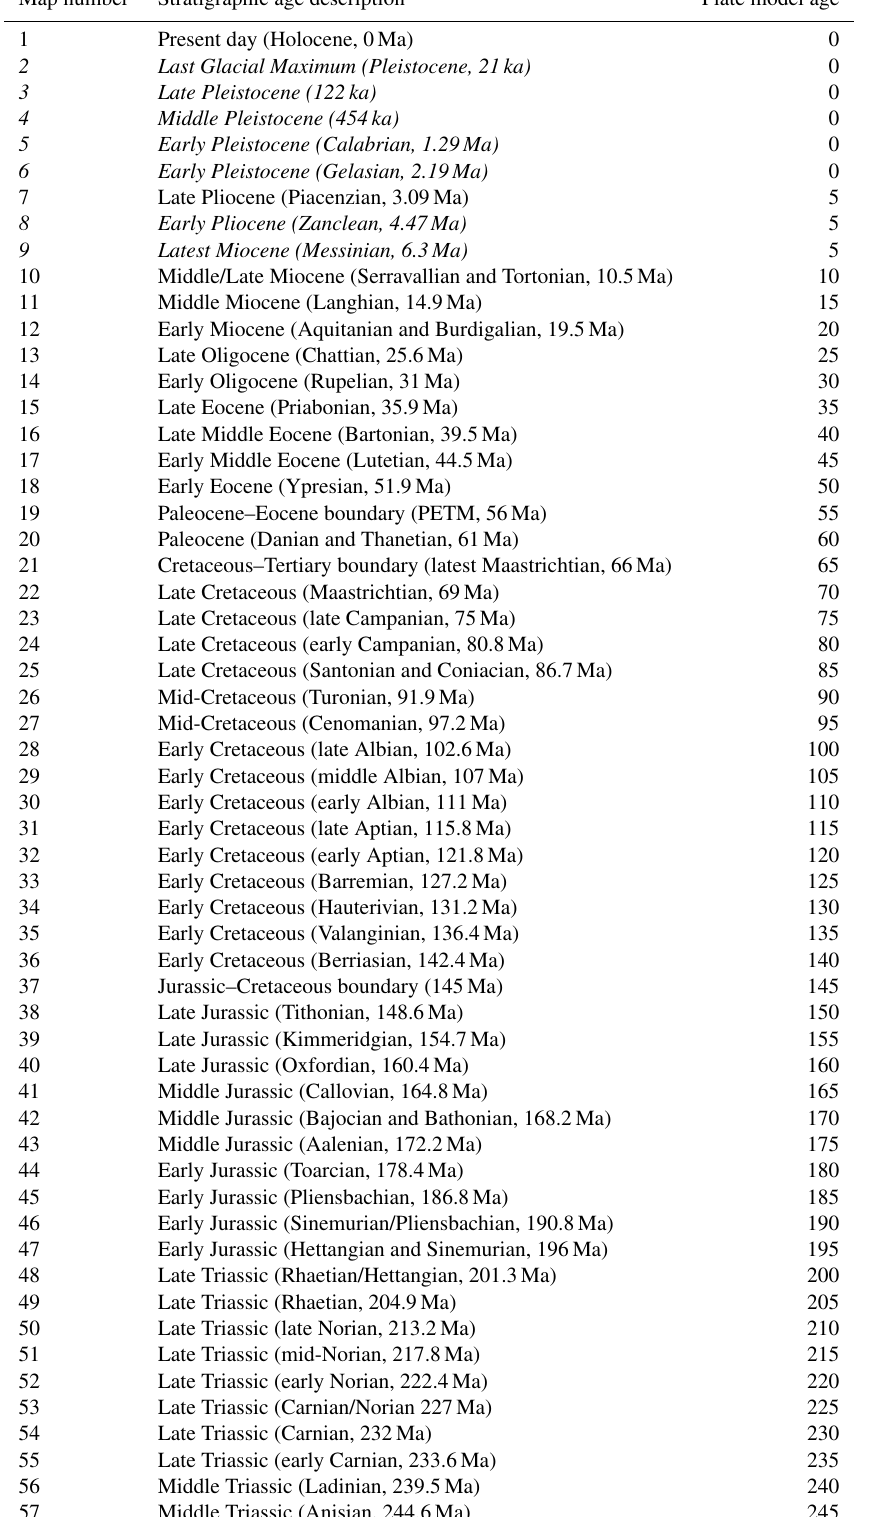
Table 1. List of paleogeographic maps and